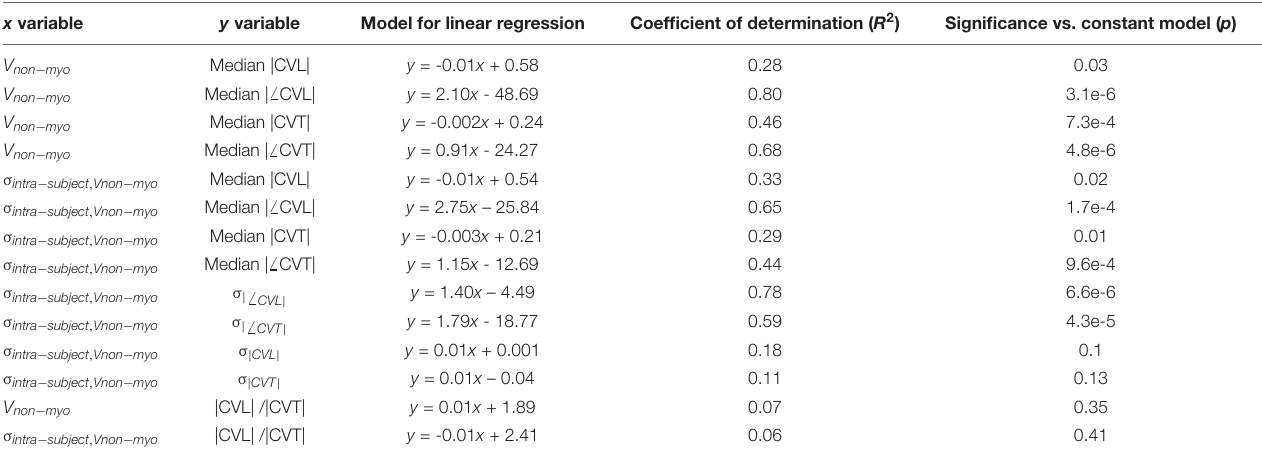
FIGURE 5 | Analysis of CV vectors in donors, IC, and NIC. (A) The probability distribution of |CVL| was widely spread in IC compared to NIC and donors. In donors, |CVL| clustered at ∼ 0.4 m/s in. Three outliers for IC between 1 and 3 m/s are not shown. (B) (cid:54) CVT is more widely spread in IC than NIC and is marginal in donors. (C) |CVT| peaks just below 0.2 m/s for donors and NIC, with NIC having a greater spread and IC spread out similar to CVT. Three outliers in IC greater than 0.5 m/s are excluded. (D) (cid:54) CVT are much smaller than (cid:54) CVL but exhibit a similar spread in the three groups. (E) Median |CVT| for each subject decreased with increasing (cid:54) CVT. (F) The median | (cid:54) CVL| increased with V nm . (G) The median |CVT| and (H) median | (cid:54) CVT| did not vary for V nm < 40% and were similar to that of CVL. (I–L) Similar relationships of CV with σ intra , Vnm as from V nm in panels (E–H) . Legend in panel (E) applies to panels (F–L) . TABLE 3 | Results of linear regression analysis between conduction velocities (CV) and fibrosis. x variable y variable Model for linear regression Coefficient of determination ( R 2 ) Significance vs. constant model ( p